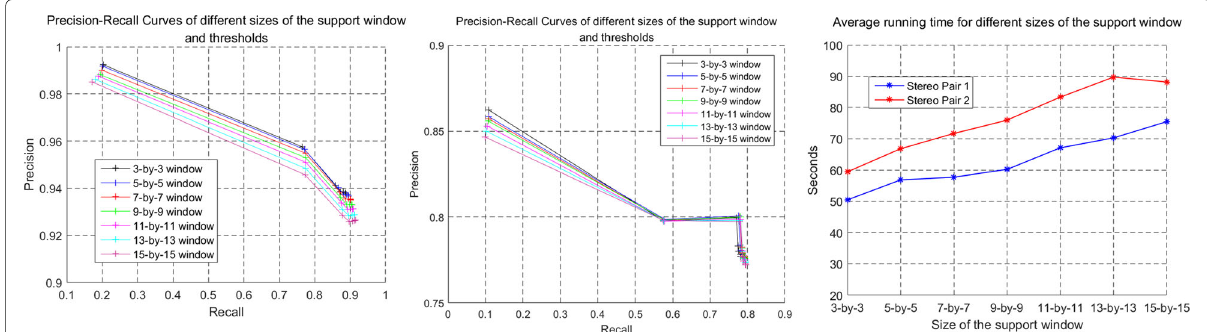
Fig. 5 Performance of the proposed method with various combinations of w and τ on the two stereo pairs. Left: the precision-recall curves of different w and τ values for the first stereo pair. Middle: the precision-recall curves of different w and τ values for the second stereo pair. Right: average running time for different values of w